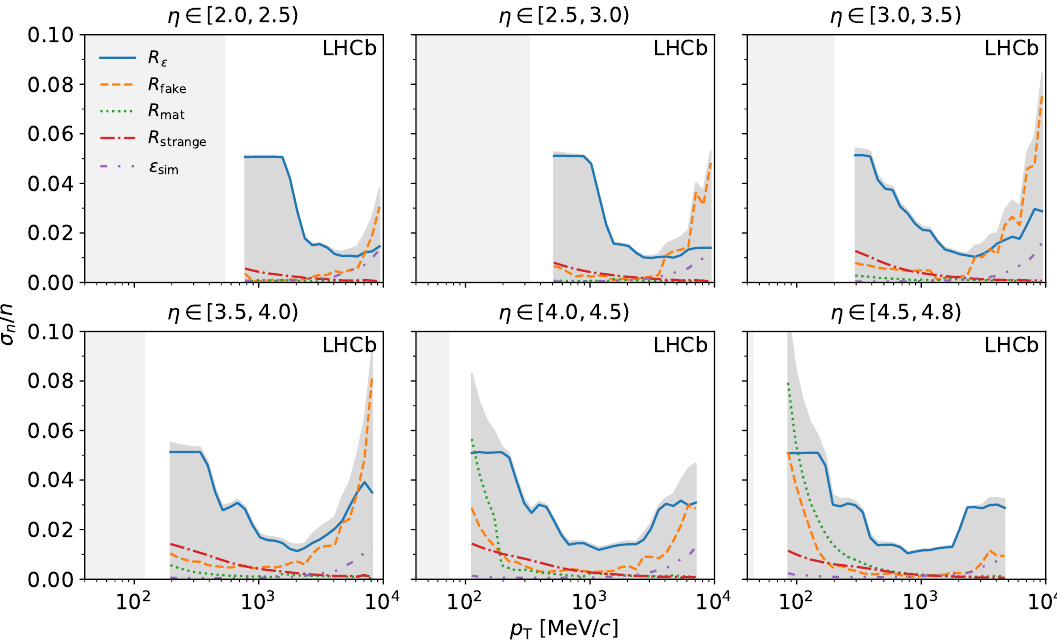
Figure 9 . Leading sources of relative uncertainties of the number of prompt long-lived charged particles in intervals of η and as a function of p T for the LHC fill recorded with the magnetic field pointing upwards. The total uncertainty, represented by the grey envelopes, excludes the uncertainty of the integrated luminosity of 2 . 0% . The light-grey areas indicate the limit of the kinematic